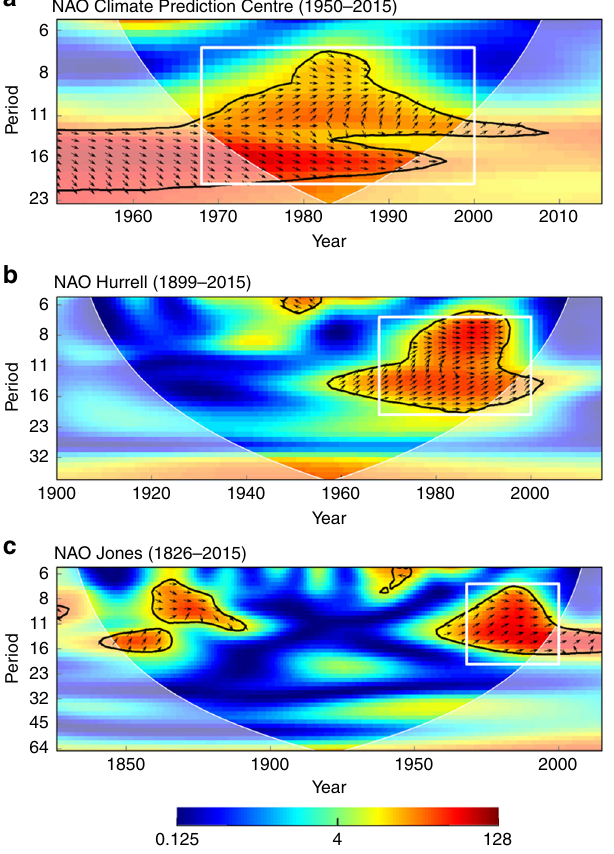
Fig. 2 Wavelet coherence between the standardized beech M_index and winter-NAO indices. Winter-NAO indices used: Climate Prediction Centre-NOAA a , Hurrell 10 b and Jones et al. 64 c . X -axes: years of analysis. Y -axes: frequency domain of the NAO-masting relationship in years. Note that the x - and y -axes vary between plots. Arrows pointing up- right show in-phase behavior and y leading x , i.e., NAO leading M_index. Black contour designates frequencies of signi fi cant coherence ( p < 0.1, two- sided test); the white cone of in fl uence shows the data space immune from distortion by edge effects. The white squares show the period of